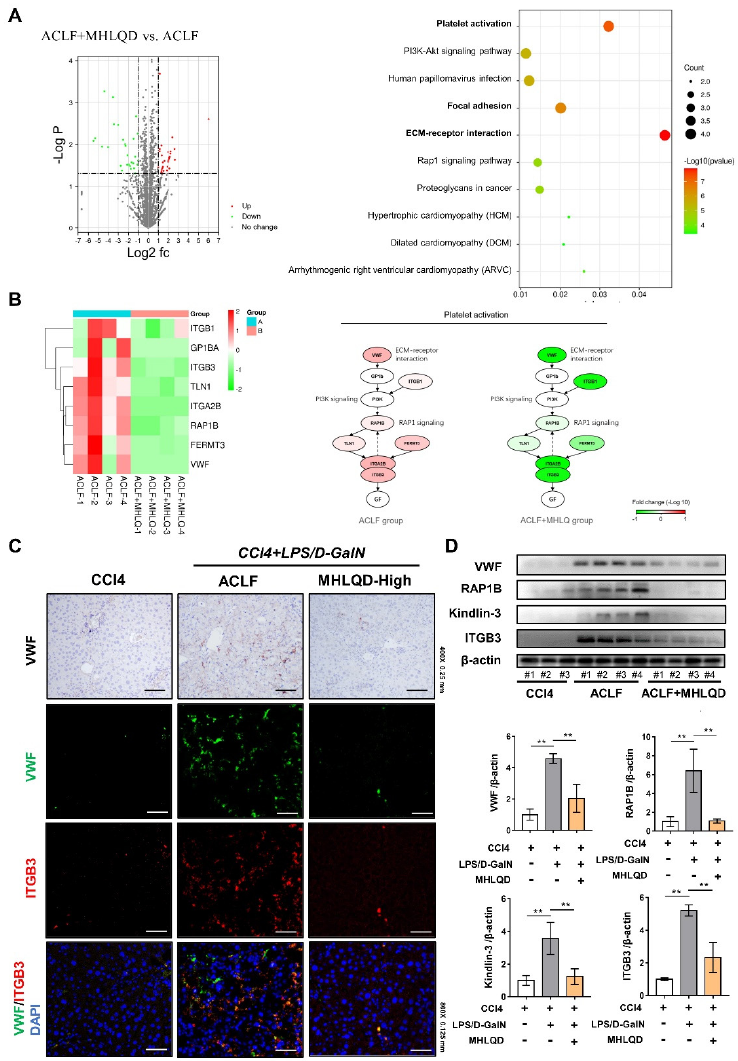
Figure 4. MHLQD inhibited VWF-induced platelet activation in ACLF mice. The mice were intraperitoneally injected with D − GalN and LPS to establish the ACLF model. MHLQD or PBS was orally administrated to mice 1.5 h before and 1.5 h after LPS/D − GalN injection. ( A ): KEGG enrichment analysis of top 10% differentially expressed proteins (DEPs) between the ACLF+MHLQD and the ACLF group. ( B ): The heatmap of protein expression and the signal transduction schema of platelet activation signaling between the ACLF+MHLQD and the ACLF group. ( C ): The immunohistochem- ical staining of VWF in liver tissues (Scale bar: 0.25 mm) and the colocalization of VWF (Green) and ITGB3 (Red) (Scale bar: 0.125 mm). ( D ): VWF-induced platelet activation signal was detected by western blot. ** p < 0.01. Abbreviation: MHLQD: MaHuang-LianQiao-ChiXiaoDou decoction, VWF: von Willebrand factor, ACLF: acute-on-chronic liver failure.